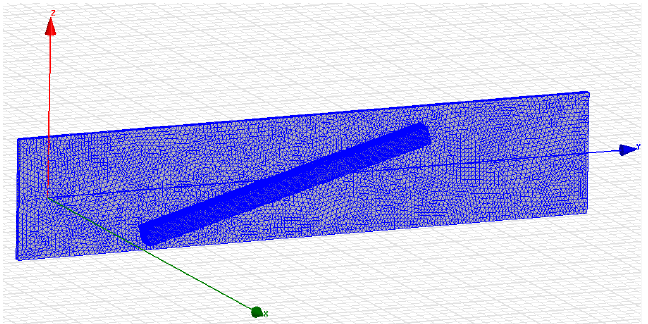
Figure 8. Mesh division of the